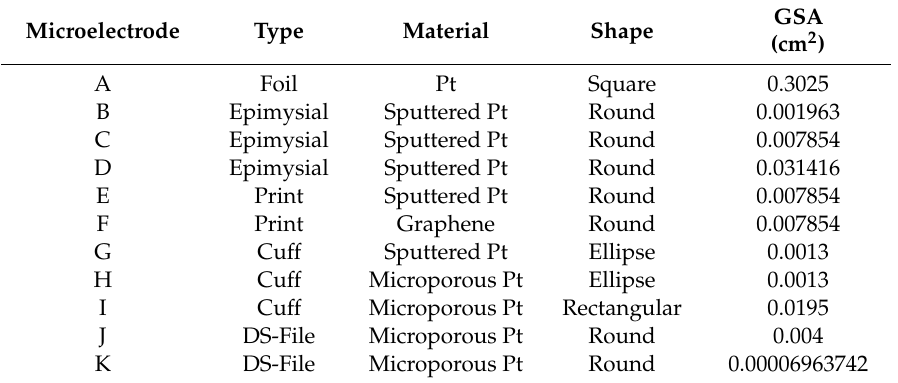
Figure 1. Microelectrodes designed and manufactured at Fraunhofer Institute for Biomedical Engineering (IBMT): ( I ) Pt foil, ( II ) Pt epimysial, ( III ) graphene printed, ( IV ) Pt printed, ( V ) Pt cuff, ( VI ) microporous Pt cuff, ( VII ) DS-File. Table 1. Microelectrodes characterized in the present study. GSA = geometric surface